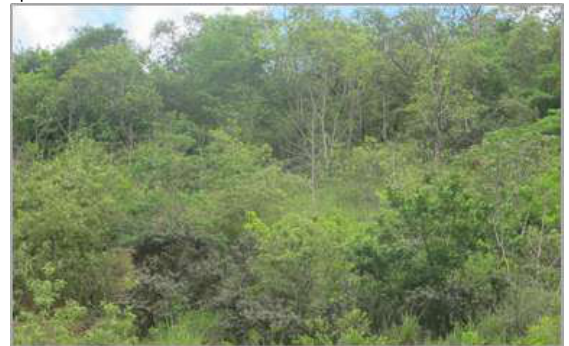
Figure 4. Types of vegetation - Early Stage in Forest Conservation